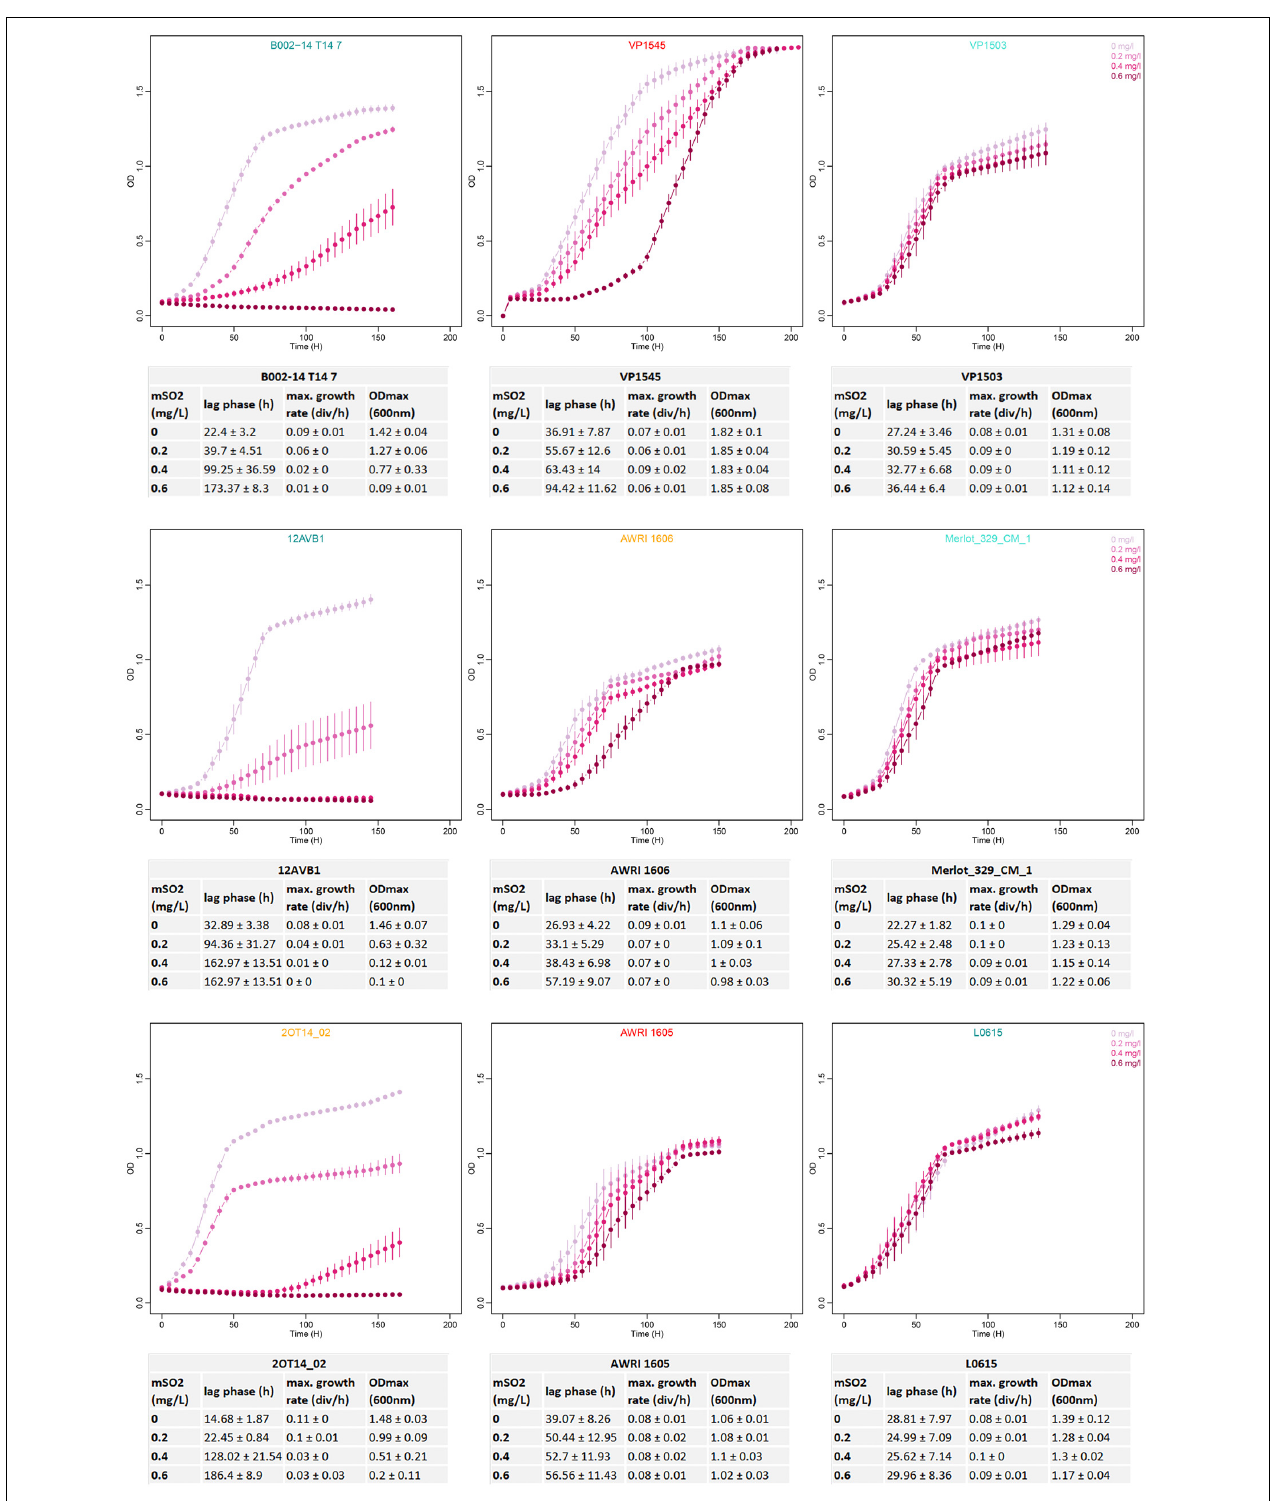
FIGURE 2 | Examples of B. bruxellensis sensitive, tolerant, and resistant behavior at four mSO 2 concentrations. Strains B002-14 T14 7, 12AVB1, and 2OT14_02 represent sensitive strains. VP1545, AWRI 1606, and AWRI 1605 are tolerant isolates and VP1503, Merlot_329_CM_1, and L0615 are examples of resistant strains. Each curve is built using the mean of three to four replicates, and error bars represent standard deviations and curve colors correspond to increasing SO 2 concentration (light pink 0 mg/L mSO 2 to dark pink 0.6 mg/L mSO 2 ). The estimated growth parameters (lag phase, maximal growth rate, and maximal OD) are shown below each curve, with mean ± standard